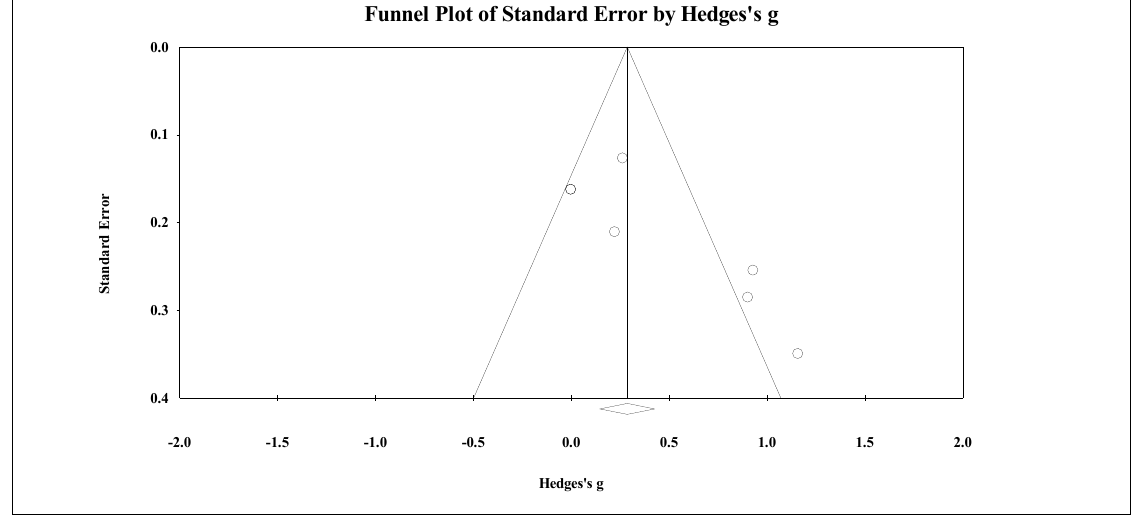
Figure 13. Funnel plot for changes in lower-body bone mineral density in untrained adults after a training program based on soccer small-sided games. White circles: observed studies.